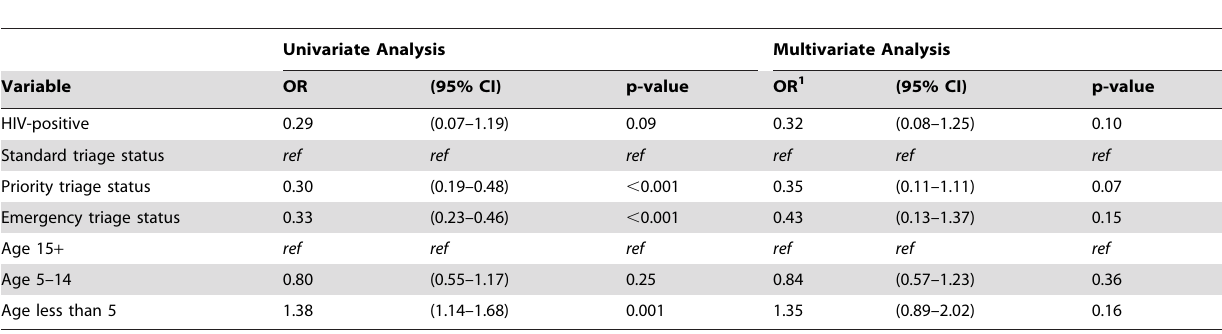
Table 4. Association between clinical exposure variables and inappropriately withholding antibiotic treatment to patients with a clinical indication for